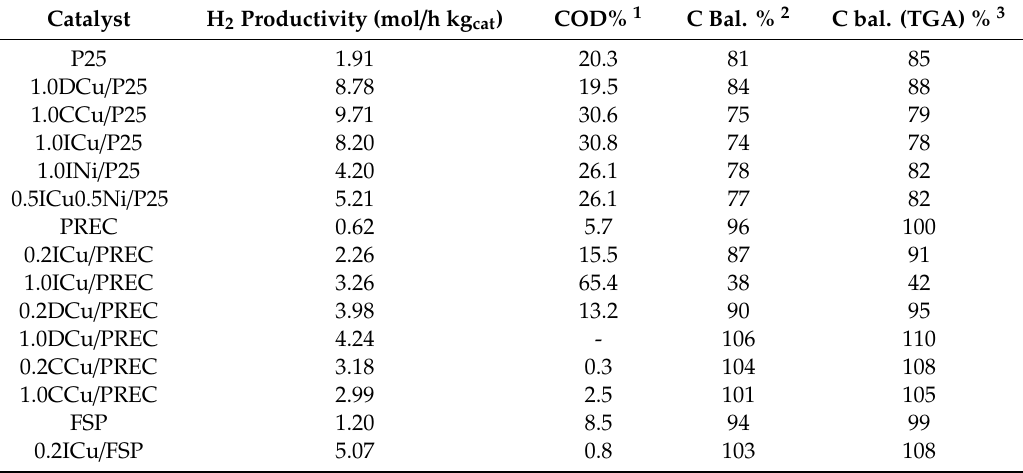
Table 2. Catalytic activity results for the photoreforming of glucose.